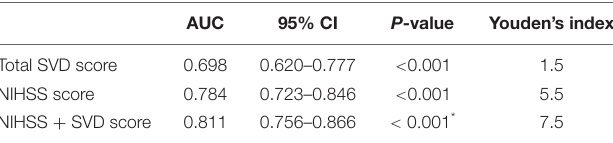
TABLE 5 | Predictive performance of total cSVD score adds to the NIHSS score using ROC analysis. AUC